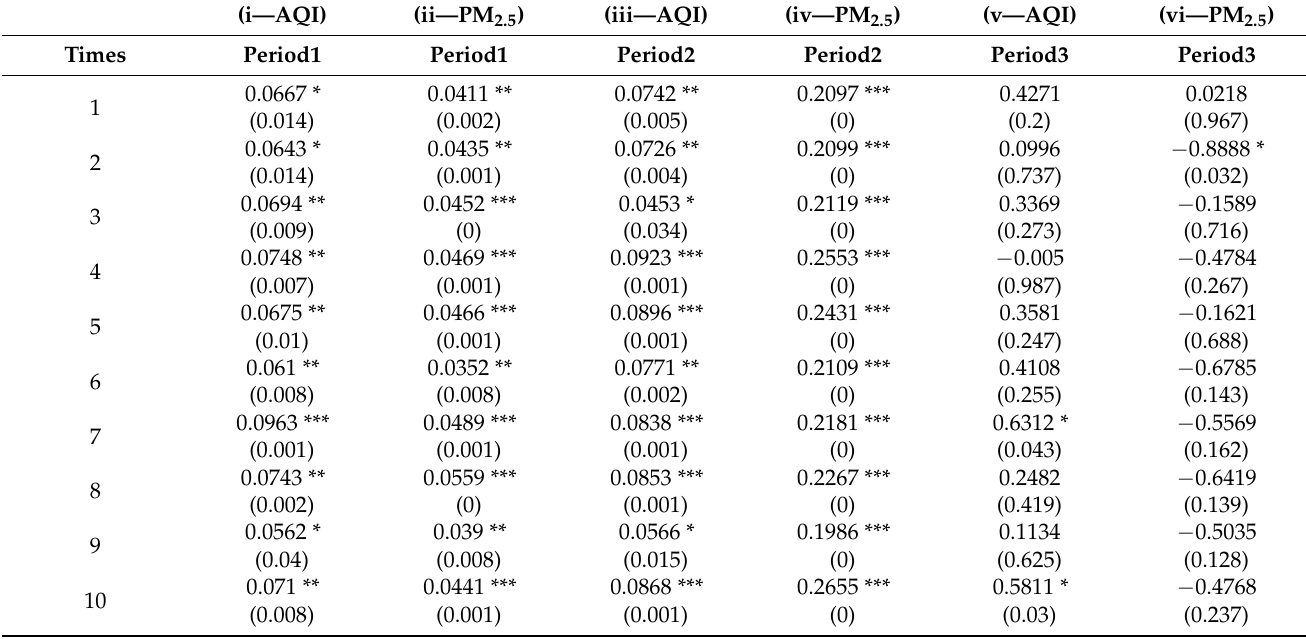
Table A9. Ten times of the effect’s estimation of air pollution on people’s activity on the randomly sampled on the house or community